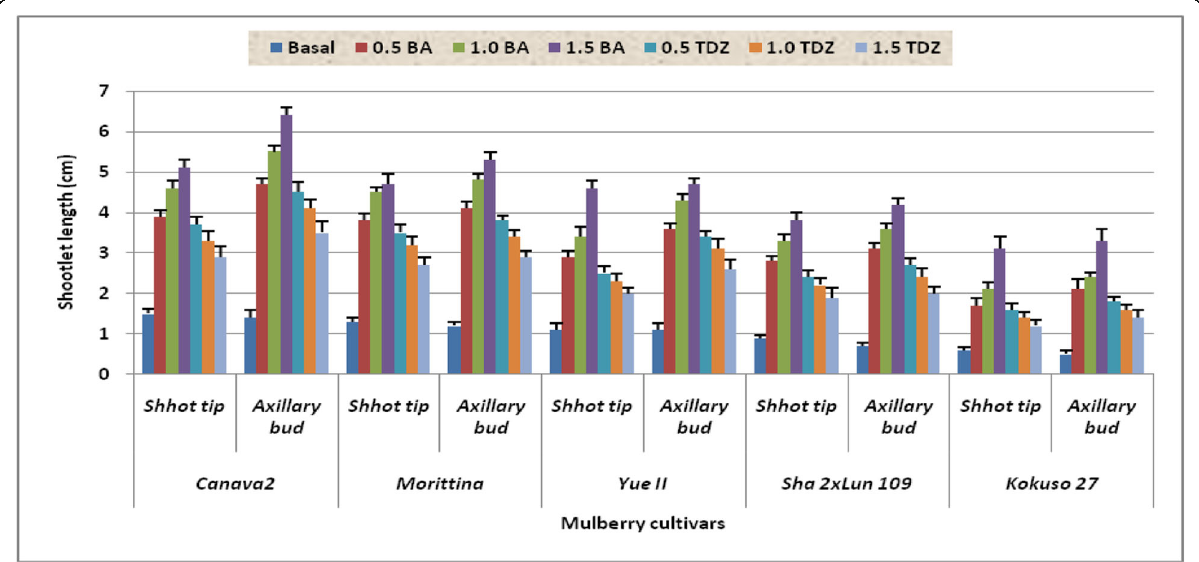
Fig. 3 Effect of BA and TDZ (mg/l) at different concentrations and type of explants (apical shoots and/or auxiliary buds) on in vitro shootlet length (cm) of mulberry cultivars. Cultures were incubated under the rhythm of light/dark condition (16/8 h). Each treatment is the average of 3 replicates ±